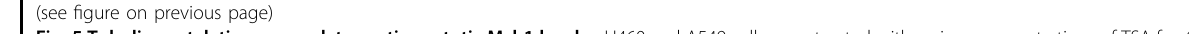
Fig. 5 Tubulin acetylation upregulates antiapoptotic Mcl-1 level. a H460 and A549 cells were treated with various concentrations of TSA for 4 h, Mcl-1, Bcl-xL, and Bcl-2 expressions were examined by western blot analysis. The blots were reprobed with GAPDH to con fi rm equal loading. The graph shows the mean ± SEM of the relative protein expression level. Student ’ s t test, * P < 0.05 vs nontreated cells ( n = 3). b H460 cells were transfected with either GFP-tagged α -tubulin N-acetyltransferase 1 wild-type (GFP- α TAT1 wt ) or its dominant-negative mutant (GFP- α TAT1 D157N ) plasmid, and immunostained for GFP (green), Mcl-1 (red), and DNA (blue). Cells were imaged by confocal microscopy. The plot shows the relative intensity of Mcl-1 in GFP-positive (asterisk) and -negative cells. Data were analyzed from GFP- α TAT1 wt cells ( n = 35) and GFP- α TAT1 D157N cells ( n = 56). Scale bars: 20 μ m. n.s. not signi fi cant. c After 30 days of paclitaxel administration, tumor nodules from normal saline (NSS)- and paclitaxel-treated groups were collected, and Mcl-1 expression was examined by western blot analysis. The blots were reprobed with GAPDH to con fi rm equal loading. The graph shows the mean ± SEM of the relative Mcl-1 intensity. Student ’ s t test, * P < 0.05 vs normal saline (NSS)-treated group ( n = 5). d Mcl-1 expressions in paclitaxel-resistant (H460/PTRX, P) and their control (H460/Ctrl, C) cells were examined by western blot analysis. The blots were reprobed with GAPDH to con fi rm equal loading. The graph shows the mean ± SEM of the relative Mcl-1 intensity. Student ’ s t test, * P < 0.05 vs passage-matched control H460 (H460/Ctrl; C) cells ( n = 3). e Paclitaxel-resistant (H460/PTRX-C7) and f patient-derived primary lung cancer ELC17 cells were transfected with either siRNA to α TAT1 or control, acetylated tubulin and Mcl-1 levels were examined by western blot analysis. The blots were reprobed with GAPDH to con fi rm equal loading. The graph shows the mean ± SEM of the relative protein intensity. Student ’ s t test, * P < 0.05 vs siCtrl cells ( n =